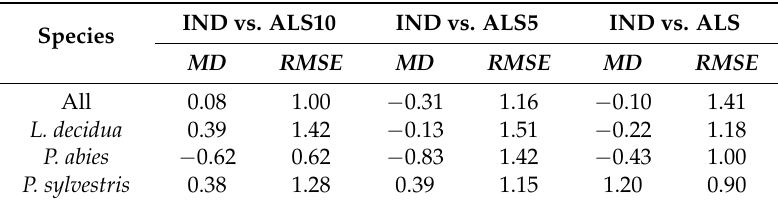
Table 4. Mean difference (MD) and Root mean square error ( RMSE ) between field indirect (IND) and ALS data for the whole dataset (All) and divided by species. ALS data are presented divided by pulse densities (10, 5, 1 points/m 2 ) obtained through point cloud thinning. IND vs. ALS10 IND vs. ALS5 Species